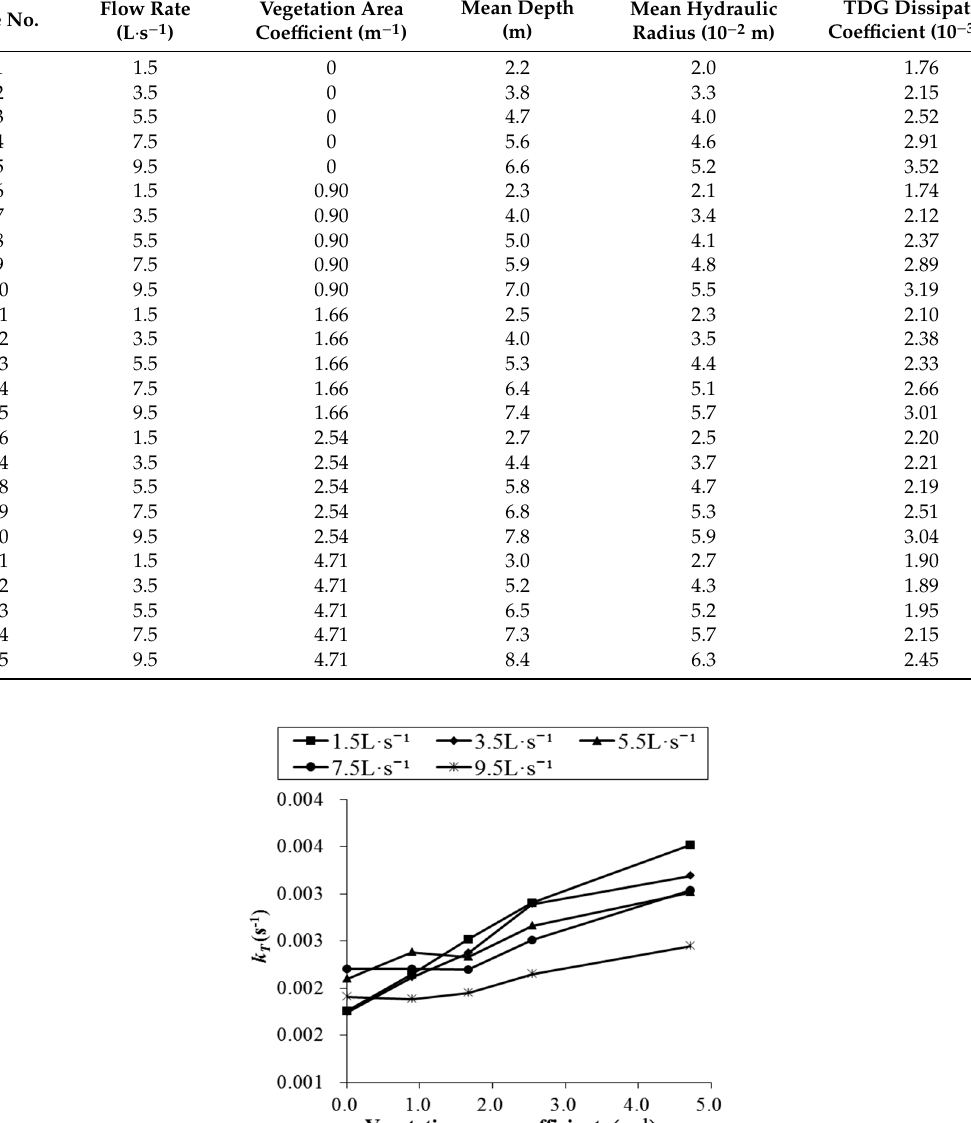
Table 2. Total dissolved gas (TDG) dissipation coe ffi cient under various conditions. Case No.